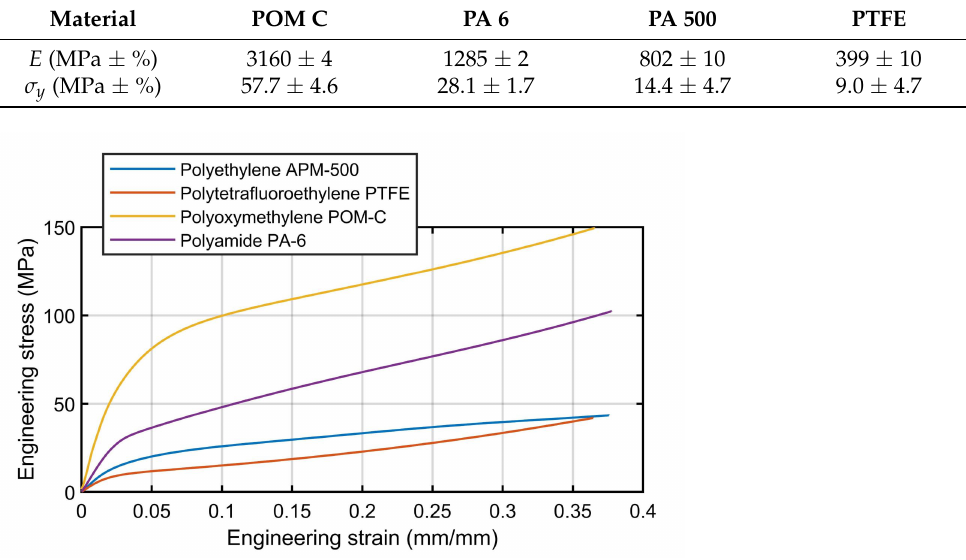
Table 2. Estimated Young’s modulus E and yield strength σ y from the compression tests. Material